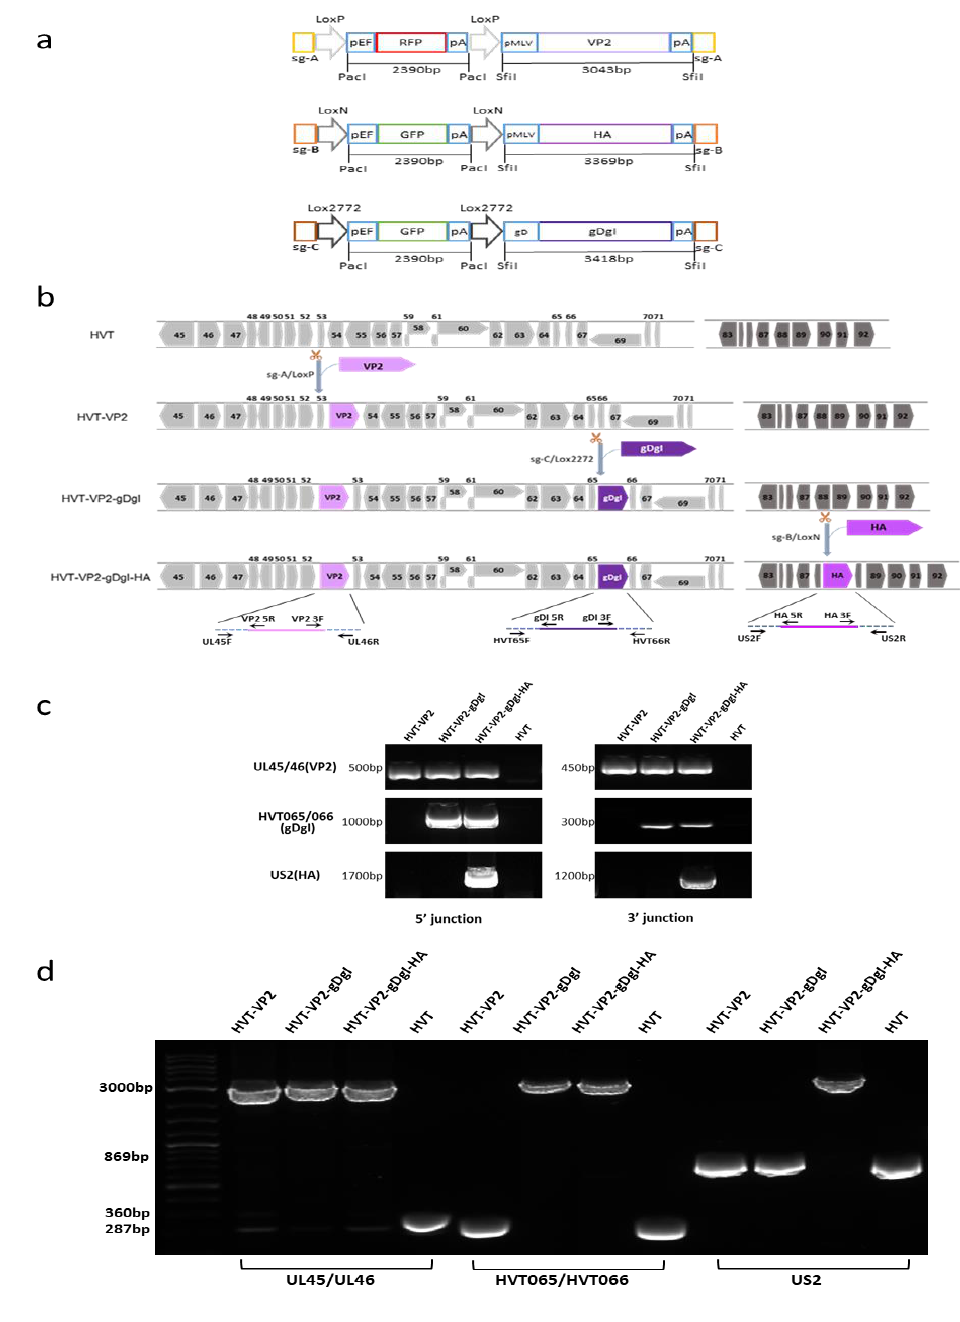
Figure 1. Construction of triple insert recombinant HVT-VP2-gDgI-HA. ( a ) A schematic representation of the cloning strategy for construction of three donor plasmids. The key elements include Cas9 target sites (sgA, sgB, or sgC) for releasing the insert, Lox sequences flanking the RFP/GFP cassette (LoxP, LoxN, or Lox2272) for the excision of the reporter, and the foreign gene expression cassette (VP2, HA, or gDgI) for insertion. ( b ) Herpesvirus of turkeys (HVT) genome regions spanning the three insertion sites used in this study with numbered HVT genes in grey/dark grey arrows and foreign gene expression cassettes VP2 (light purple, GenBank accession number: D00869), HA (purple, GenBank accession number MT039488.1) and gDgI (dark purple, GenBank accession number of ILTV: MN335811.1). The scissor icon represents the gRNA targeting sites in the HVT genome for foreign gene insertion. The name and position of the primers used for each PCR are shown in arrows at the bottom. ( c ) 5’ and 3’ junction PCR to confirm the correct insertion of genes